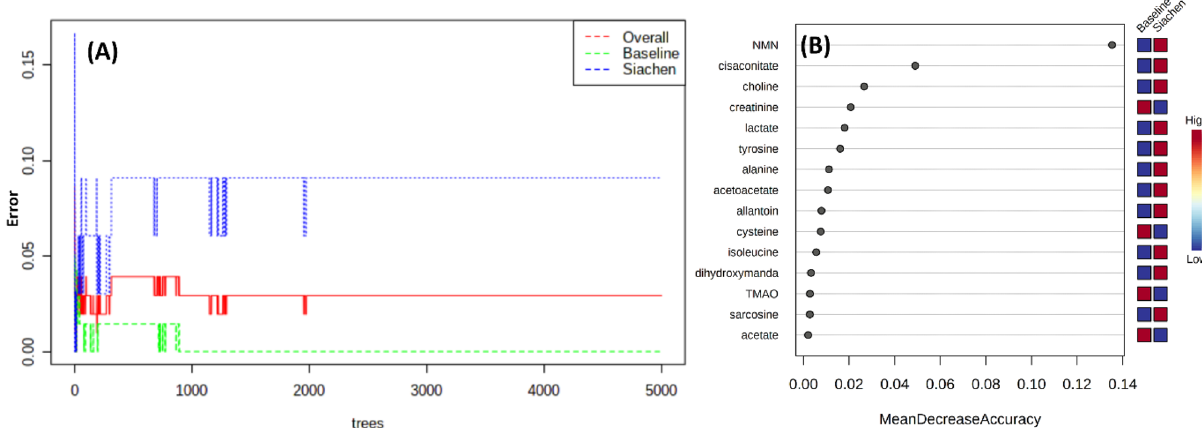
Figure 8. ( A ) Cumulative error rates by Random Forest classification. ( B ) Significant features identified by Random Forest. The features are ranked by the mean decrease in classification accuracy when they are permuted.